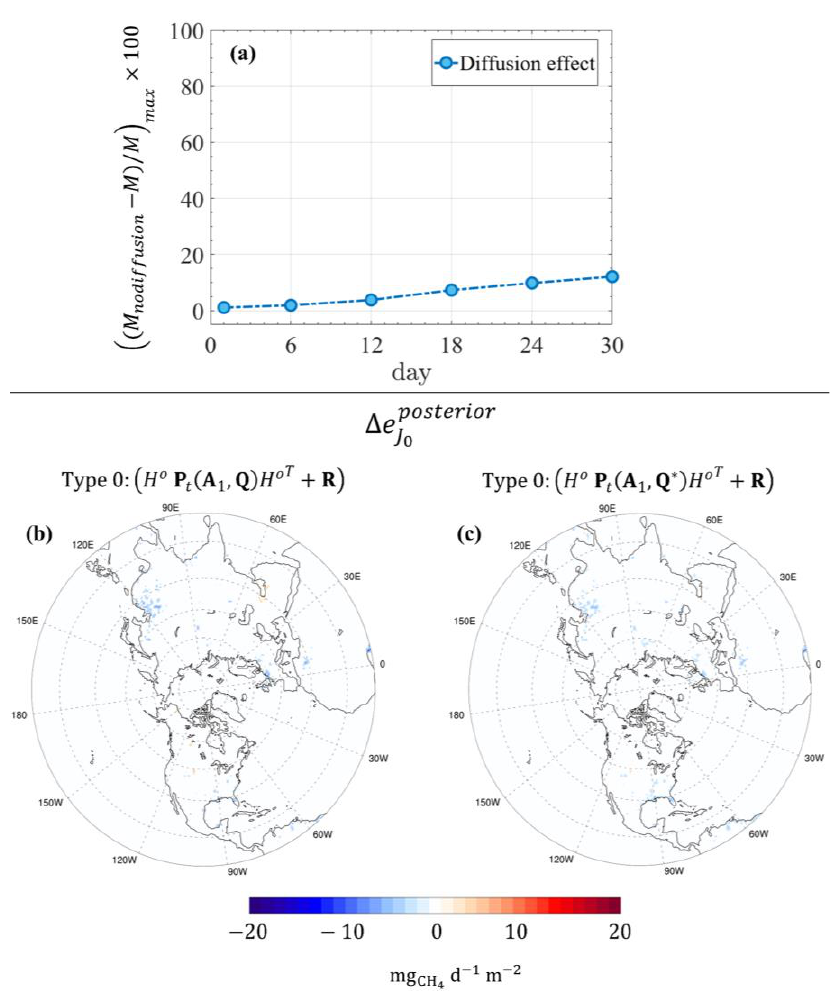
Figure A2. ( a ) Diffusion effect of model error ( Q dif fusion ) estimated using a series of forecast simula- tions. Comparison between posterior–true emissions of Type 1 of Section 3.3 (based on ± 25–50% non-uniform perturbation) where ( b ) uses model error covariance Q = Q PvKF and ( c ) uses model error covariance Q ∗ = Q PvKF + Q dif fusion .